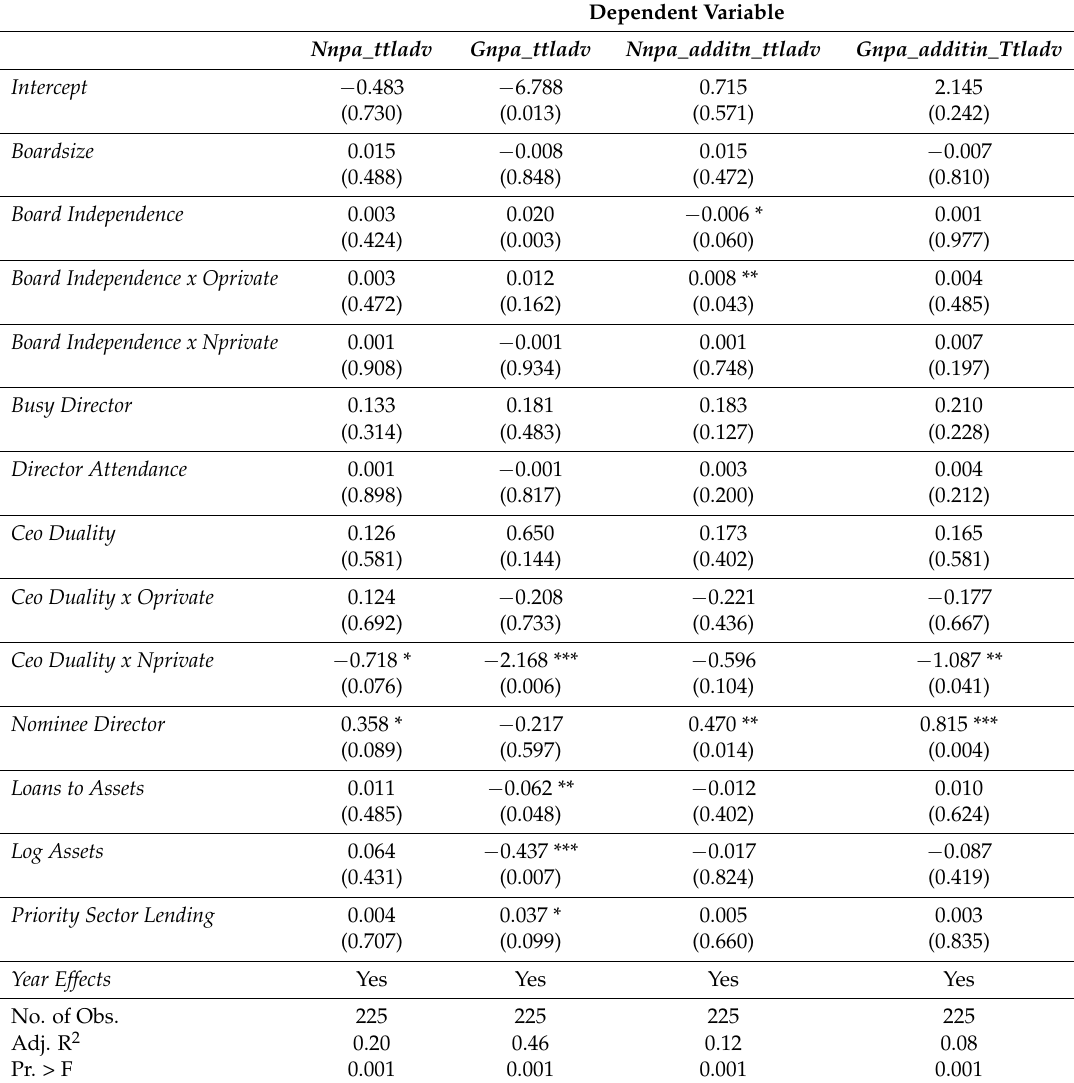
Table 6. Board Characteristics and Bank Asset Quality: Dependent Variable—Asset Quality